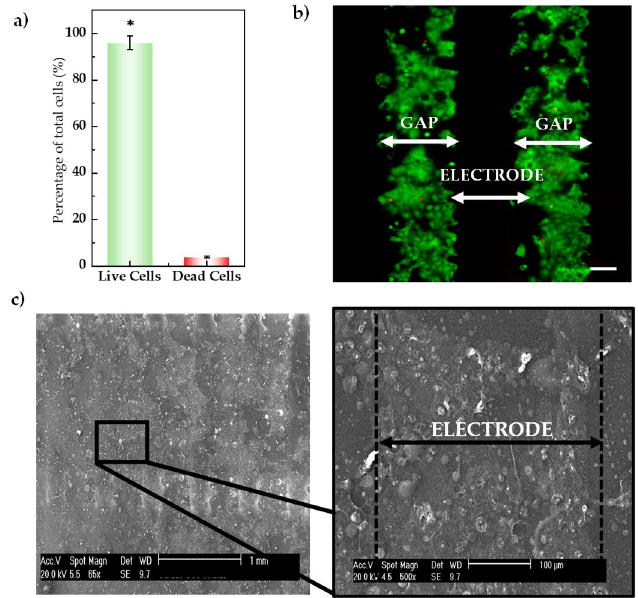
Figure 4. ( a ) Live/dead assay on the HaCaT cell line after 3 days of incubation. Distribution of live and dead cells of a total of 60 images of areas around different electrode sites on IDEs was analyzed. The error bars represent the observed standard deviations. ( b ) Fluorescent image of the surface of two consecutive fingers of the electrodes (scale bar 100μm) showing a simultaneous detection of the live and dead cells is observed, in which the live cells can be seen in green while the red spots identify dead cells. Owing to the non-transparency of the conductive lines (AgNP), stained cells can be observed only on the gaps of the interdigitated electrodes, as the sample was illuminated from below. ( c ) SEM image of the IDEs covered by a confluent layer of HaCaT cells (scale bar 1mm), confirming that when stained cells are observed in the gaps of the interdigitated fingers, they were also over the electrode lines. The magnification of one area is highlighted showing cells adhered to the surface of the electrode (scale bar 100μm).